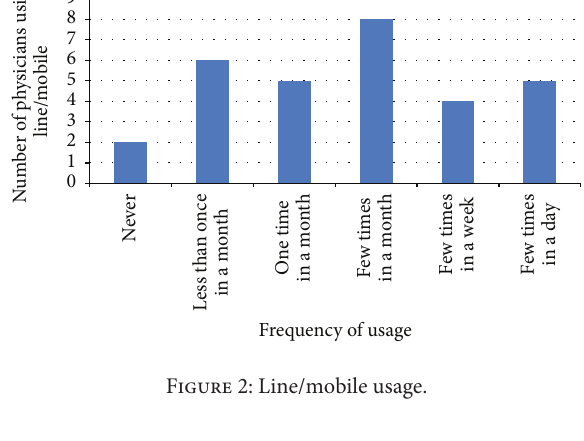
Table 1: Operationalization of the factors and items.